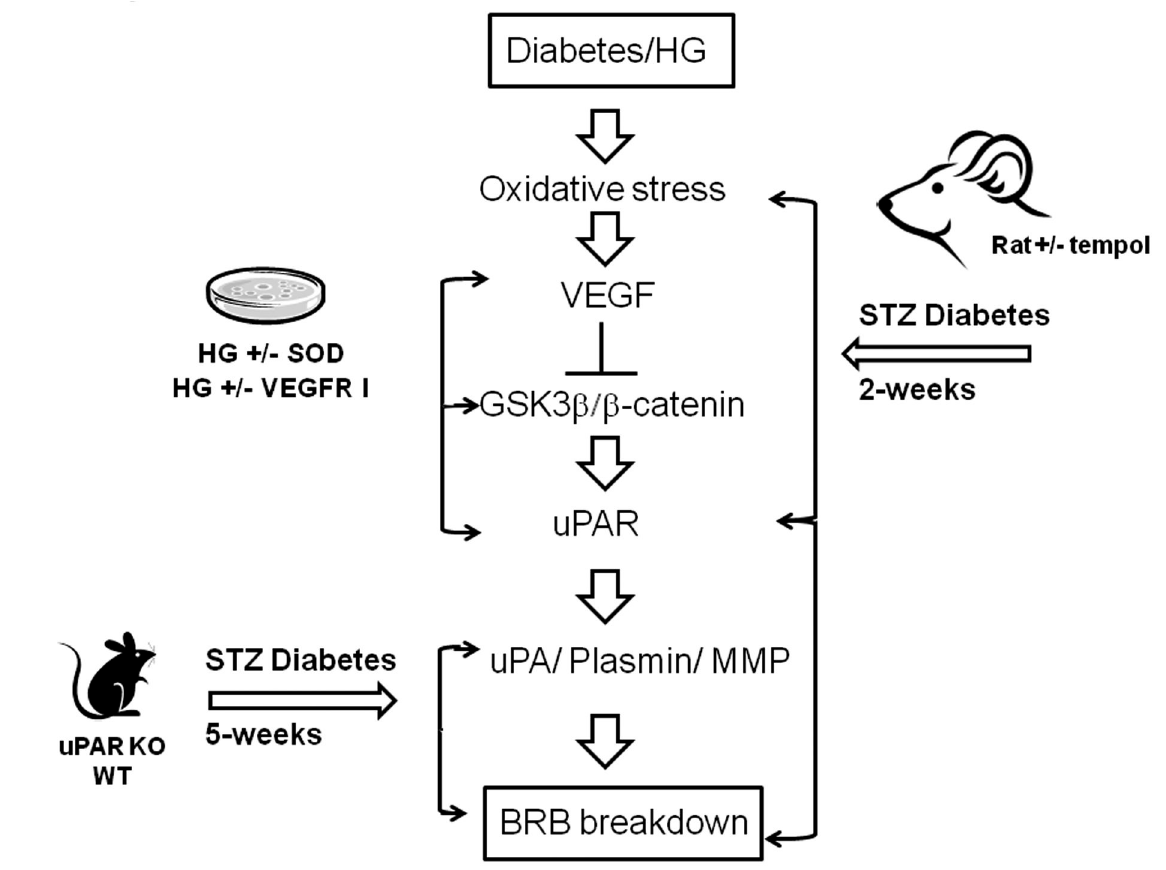
Figure 8. Hypothesized scheme of events. for how diabetes/hyperglycemia induced oxidative stress triggers VEGF-mediated uPAR expression and consequent BRB breakdown, and the experimental approaches that produced the supporting